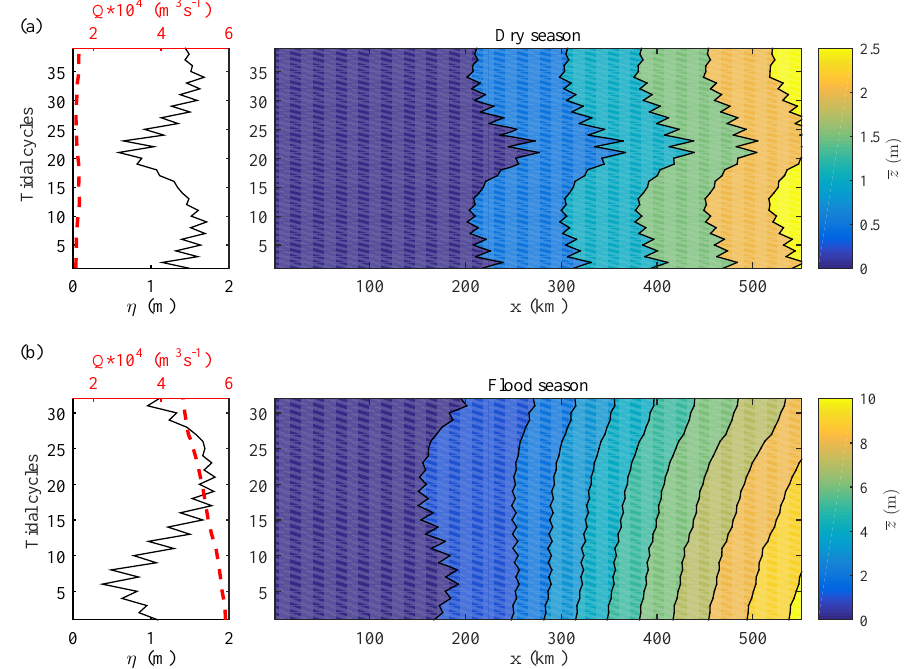
Figure 10. Longitudinal variation of the mean water level along the Yangtze estuary axis as a function of time for the dry season (a) and flood season (b) . The left panel shows the corresponding observations of tidal amplitude at Hengsha station and fresh water discharge at Datong